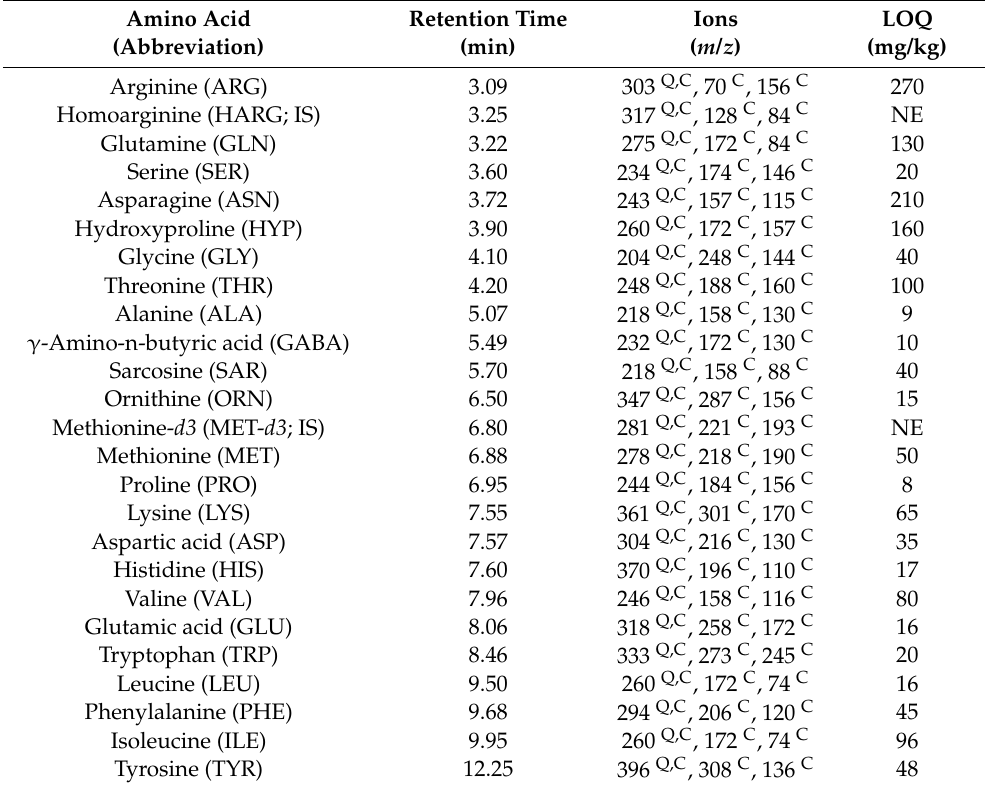
Table 2. HPLC-MS data and limits of quantification for the studied free amino